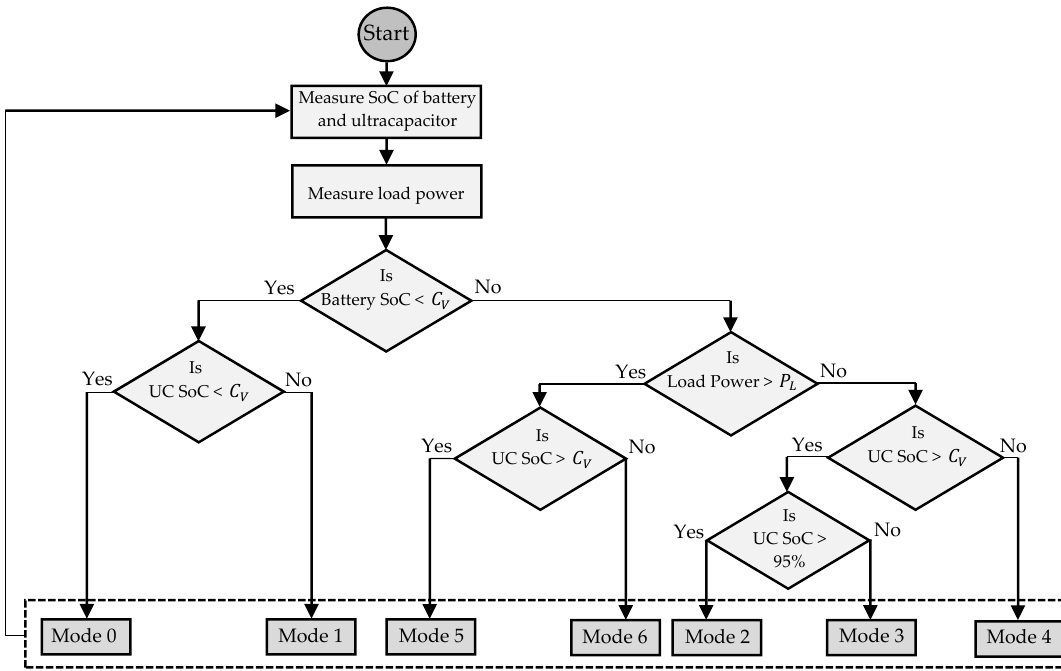
Figure 3. Overhead Control Rules .